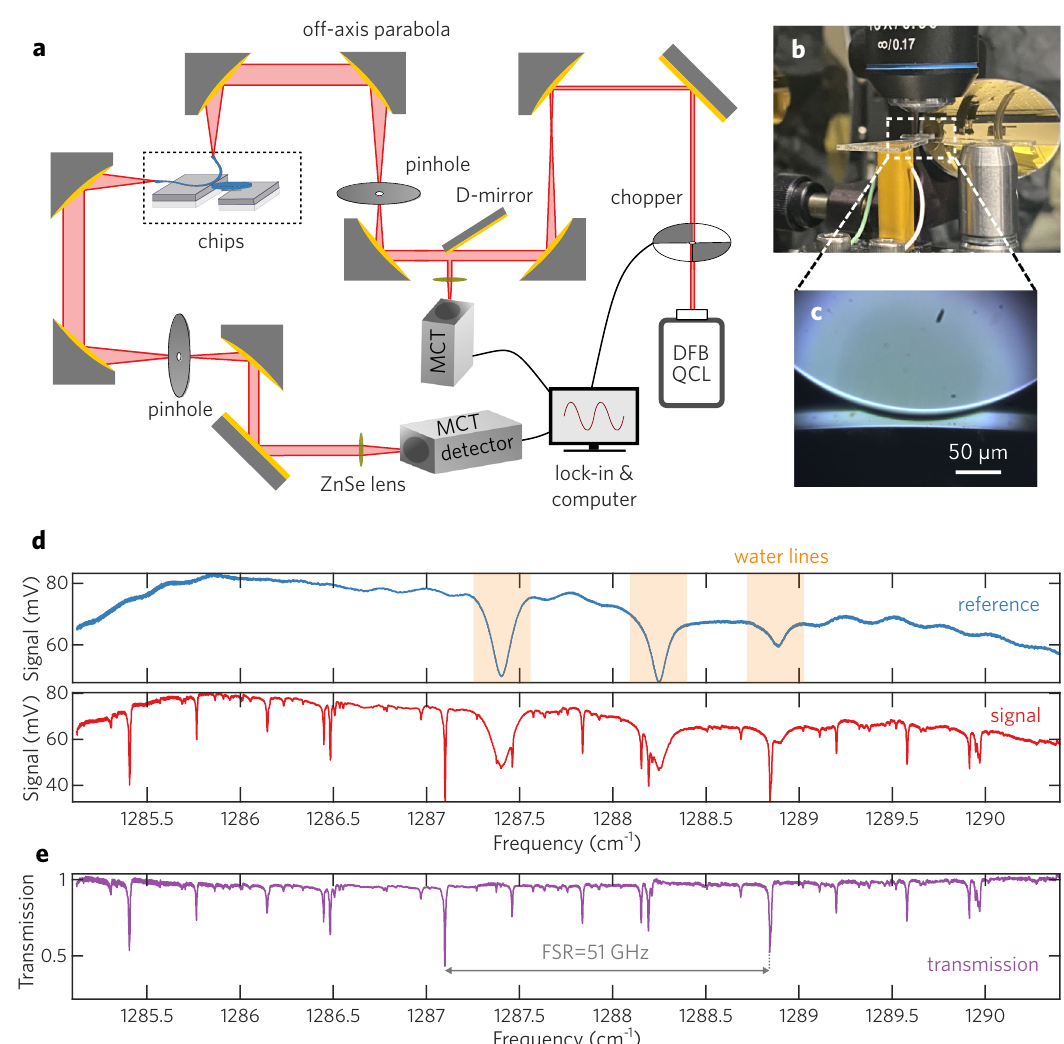
Fig. 3 | Experimental setup for transmission measurements. a Schematic of the optical path and components. A DFB QCL is focused into the waveguide and cou- pled to the resonator. b Photograph of the coupling setup. The glass chip with microresonator is mounted on the piezoelectric actuator in yellow and waveguide chip is mounted on the metallic post on the right. c Optical image of the Ge WGM